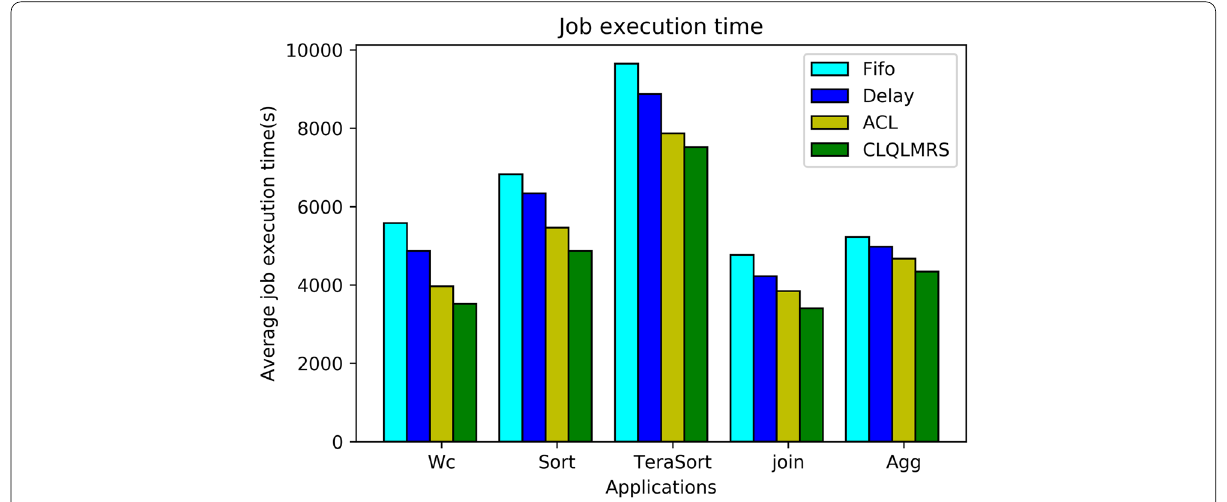
Fig. 9 Average job execution time for different applications